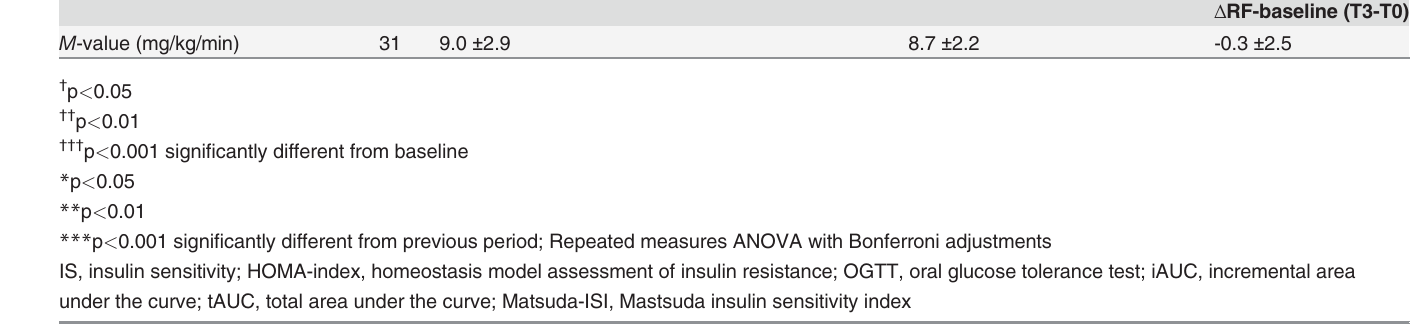
Fig. 3, due to CR, IS (HOMA-index, Matsuda-ISI) improved and fasting insulin as well as insu- lin secretion (insulin-tAUC/glucose-tAUC and Stumvoll-Index) decreased. All parameters normalized again upon RF (Fig. 3; Table 2). Fasting glucose levels decreased due to CR and re- mained unchanged upon RF (Table 2). Levels of leptin, leptin/FM, adiponectin, fT3, TSH as well as norepinephrine excretion significantly decreased with CR (Table 3). All parameters in- versely changed upon RF. Fasting and postprandial ghrelin (ghrelin-iAUC) improved with RF. Whereas fT4 decreased with RF, leptin/adiponectin-ratio and epinephrine excretion remained unchanged during all intervention periods.